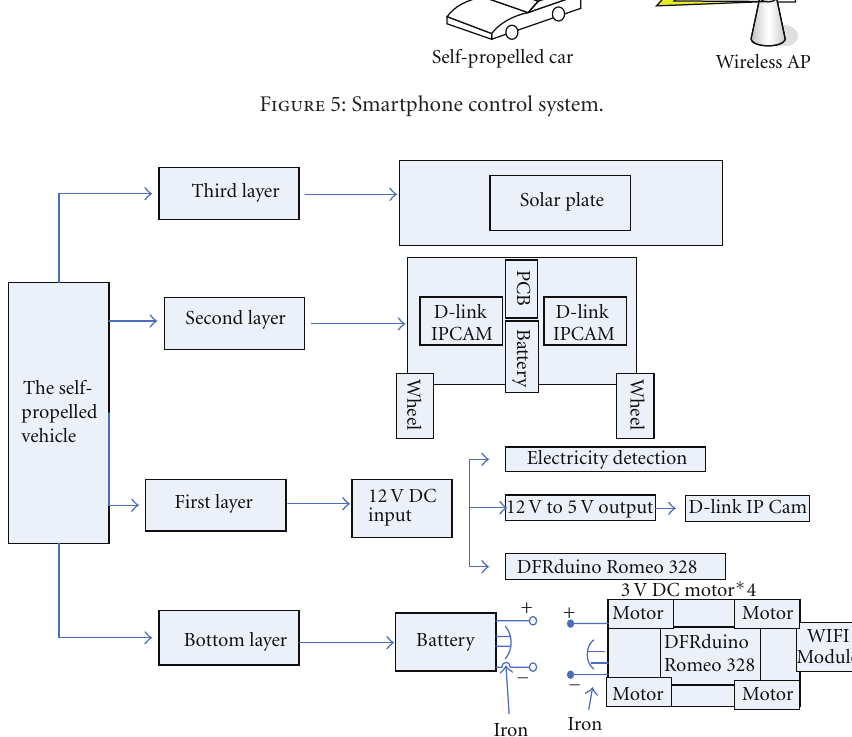
Figure 6: The hardware architecture of the self-propelled vehicle.